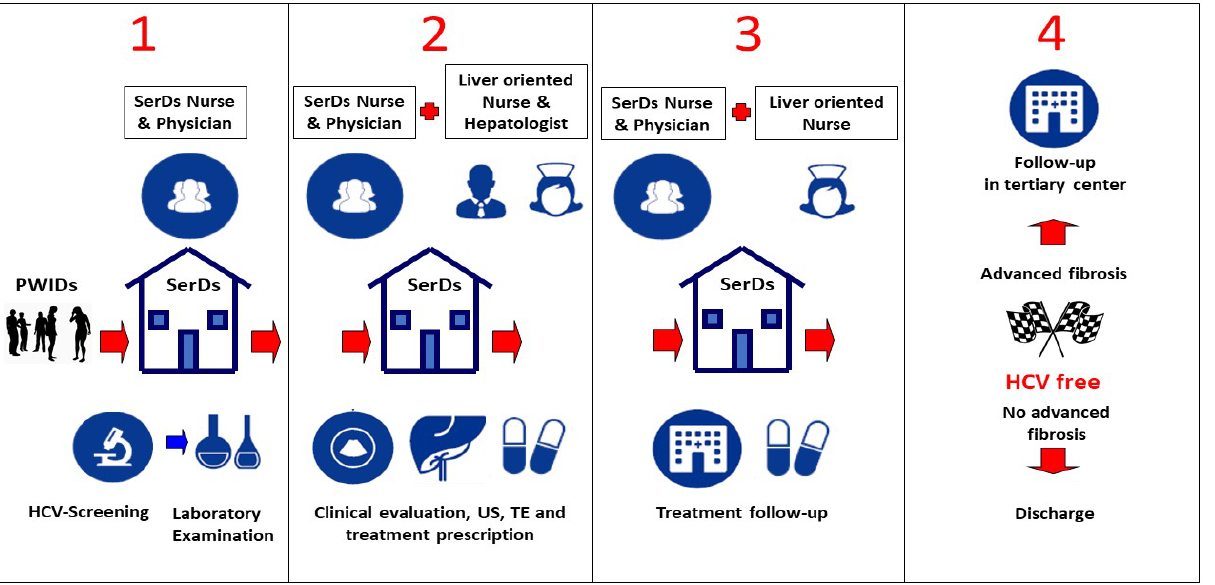
Figure 1. Model of care representing multidisciplinary approach in SerDs. SerDs, specialized outpatient centers for drug addicts; PWID, people who inject drugs; US, ultrasonography; TE, transient elastography.